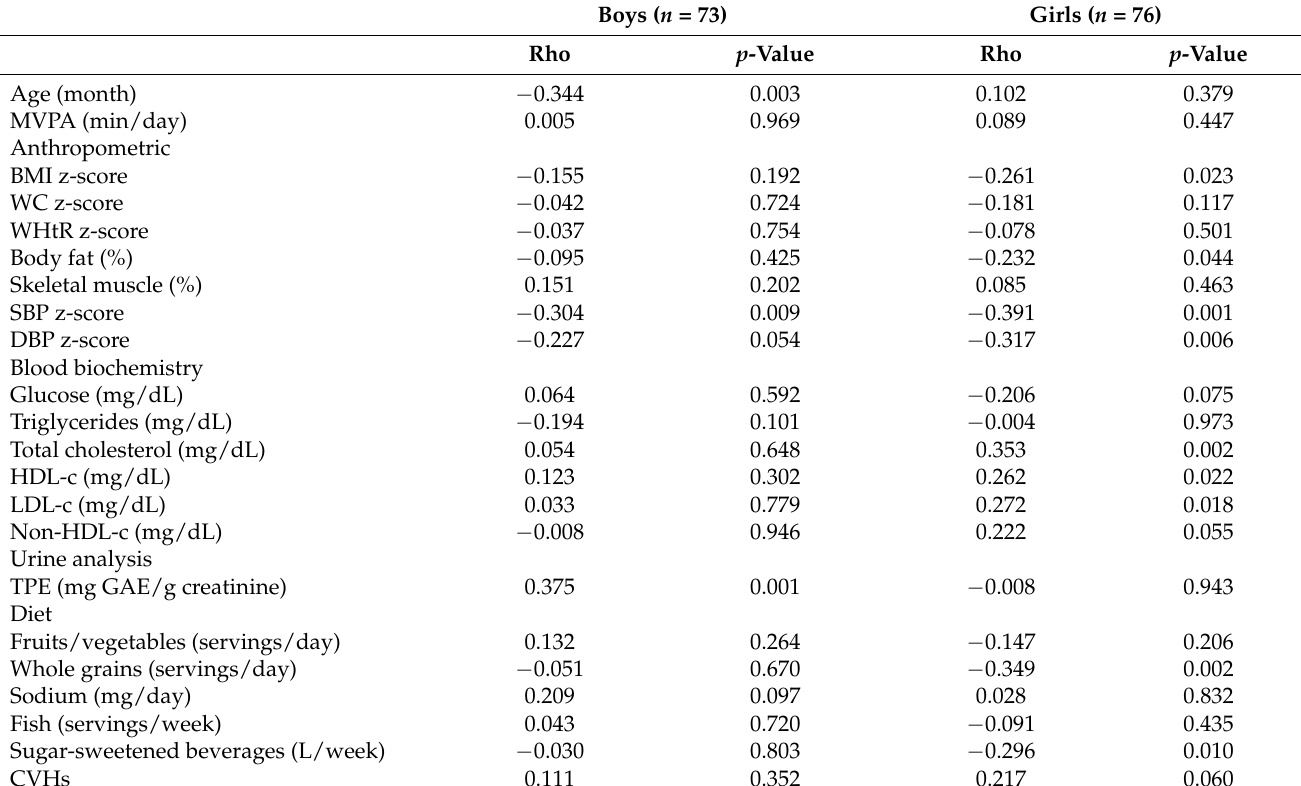
Table 4. Spearman’s correlations of nitric oxide with anthropometry, biochemical, physical activity, and dietary parameters by